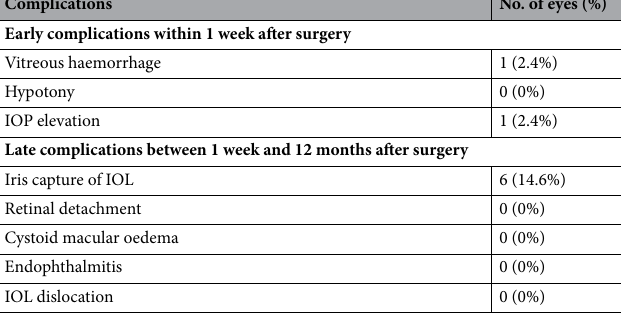
Table 2. Postoperative complications. IOL, intraocular lens; IOP, intraocular